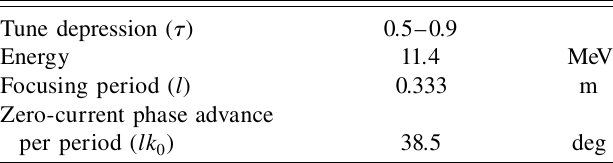
TABLE I. Parameters for the transport channel in the particle-core model.